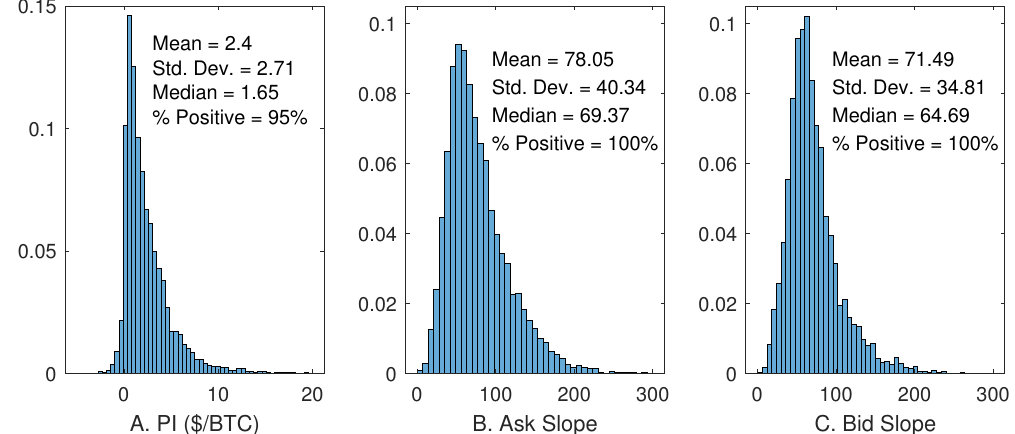
Figure 6. Summary statistics of adverse selection and liquidity provision measures. Panel ( A ) is the histogram of hourly price impact of order book events (in $ per one-coin order flow imbalance). Panels ( B , C ) are the slopes of the limit order book on the ask and bid sides respectively. The y -axis shows the probability of each data bin. Data are from BTC-e for the period from 7 December 2013 to 24 September